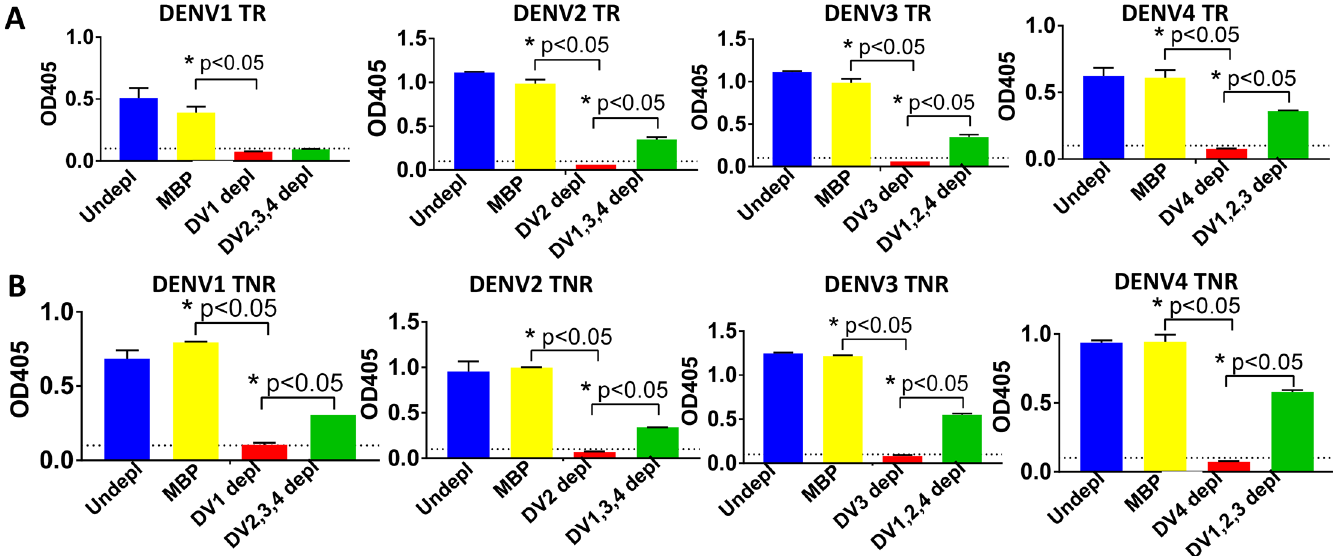
Fig 6. Tetra NP-rE induces serotype specific IgG responses in a tetravalent background. A DENV rE depletion assay was used to estimate the proportions of serotype-specific and cross-reactive antibody panels in sera of mice immunized with tetravalent vaccine formulations. Serum was incubated with magnetic beads coated with rE of DENV1, 2, 3 or 4 and serotype specific IgG titers were determined against all 4 rE serotypes for A) TR and B) TNR tetravalent formulations. For example, to establish complete exhaustion (red bars) of all serotype-specific and cross-reactive DENV1 binding antibodies, sera was depleted with DENV1 rE. To determine the DENV1 serotype-specific portion (green bars), the same sera was depleted with DENV2, 3 and 4 rE. A negative control or handling control depletion (yellow bars) was performed using maltose binding protein (MBP). Statistical differences were determined by one-way ANOVA followed by Tukeys test (p < 0.05).